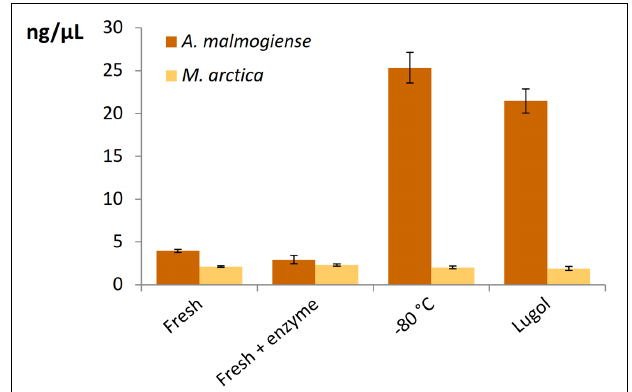
FIGURE 7 | The effect of storage and additional enzymatic lysis steps on the DNA yields of A. malmogiense and M. arctica . DNA was extracted using Power Biofilm kit from fresh cells with or without additional enzymatic step or from cells stored at –80 ◦ C or in